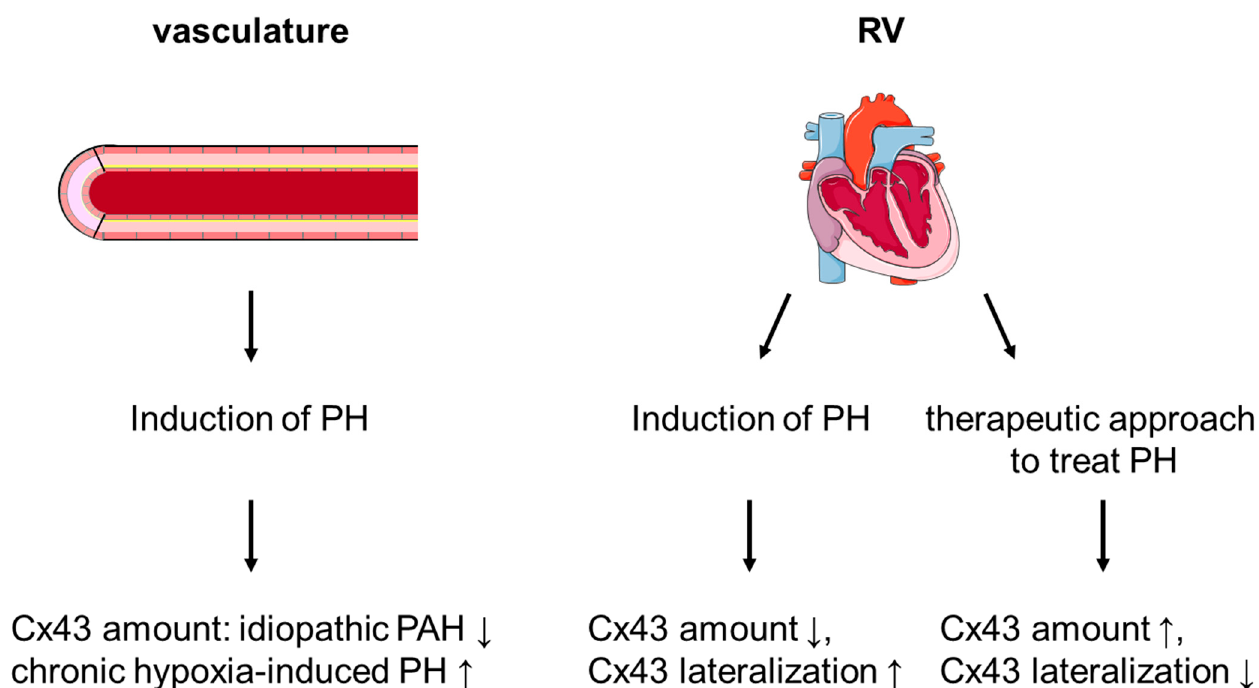
Figure 2. Schematic representation of the expression and localization of Cx43 in pulmonary hypertension (PH). In the vasculature, the amount of Cx43 depends on the exact form of PH. In the right ventricle (RV), PH is associated with a downregulation of Cx43 as well as with enhanced lateralization of the protein. Therapeutic approaches to treat PH can maintain Cx43 expression and localization. Schematic representation of the heart: copyright © 2005, Les Laboratoires Servier. PAH: pulmonary arterial hypertension.